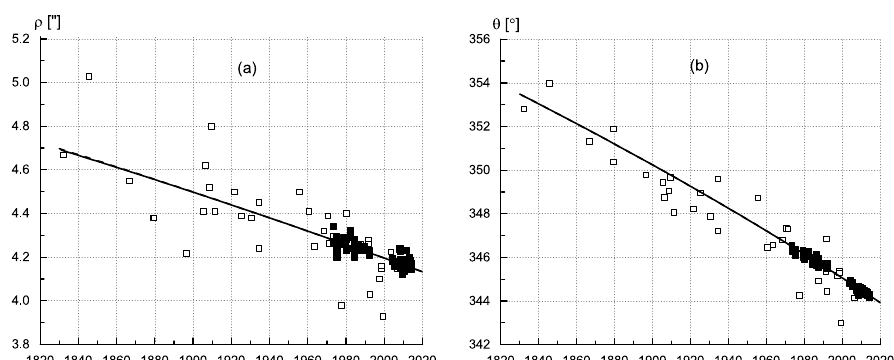
Fig. 4. HIP 66195. Same notations as in Fig. 2. The solid curves (cid:12)t ephemerides of both